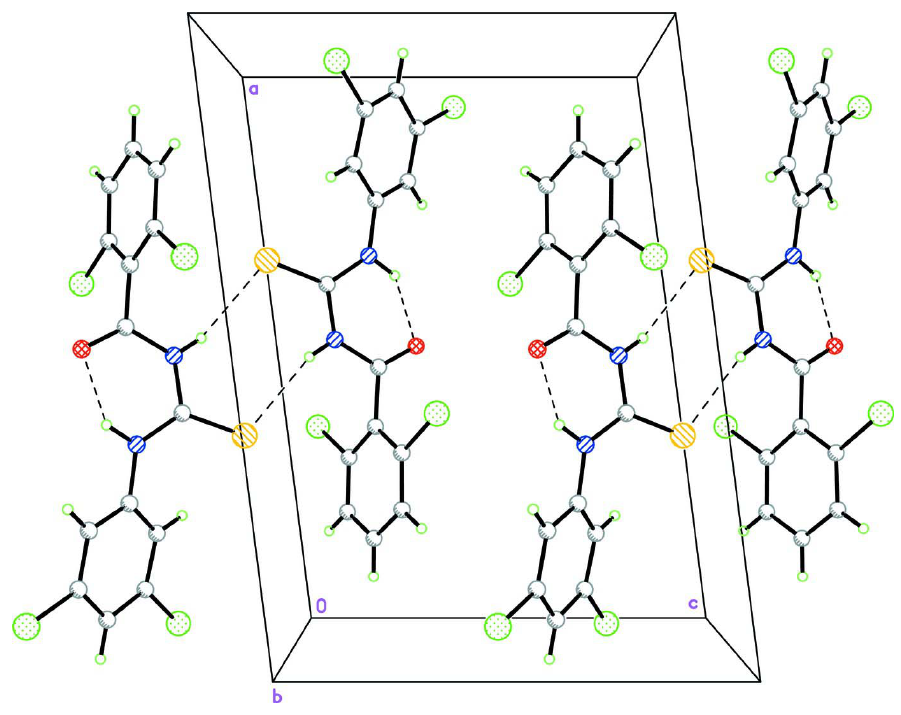
Figure 2 Partial packing diagram of (I) with view onto the ac plane. Hydrogen bonds shown as dashed